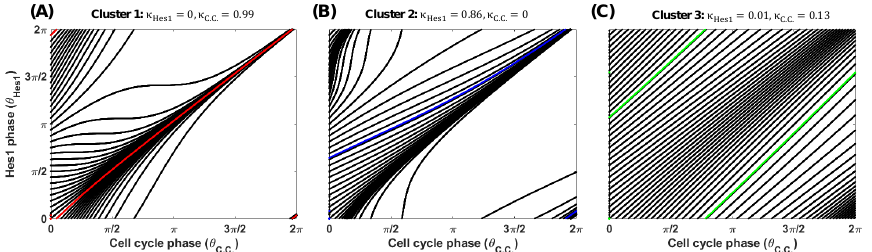
Figure 10. Torus diagram trajectories for one simulation of Equation (5) at uniformly spaced θ Hes1 ( t 0 ) initial conditions with optimal parameters for cluster 1 in panel ( A ), cluster 2 in panel ( B ) and cluster 3 in panel ( C ), as stated in Table 2. Red, blue and green trajectories in panels ( A–C ) here are the same as the black trajectories in Figure 6A–C,